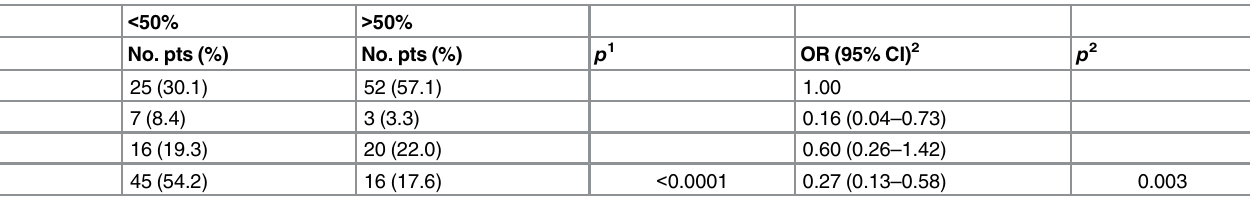
Table 2. Changes in NLR and PSA response rate at 4 weeks.